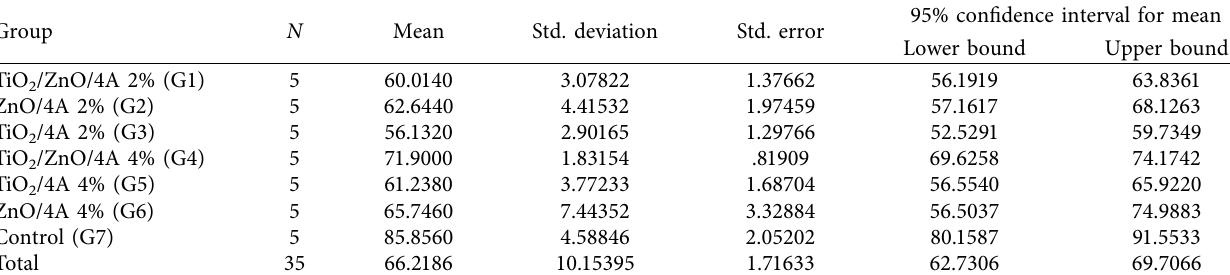
Table 3: Descriptive values of flexural strength